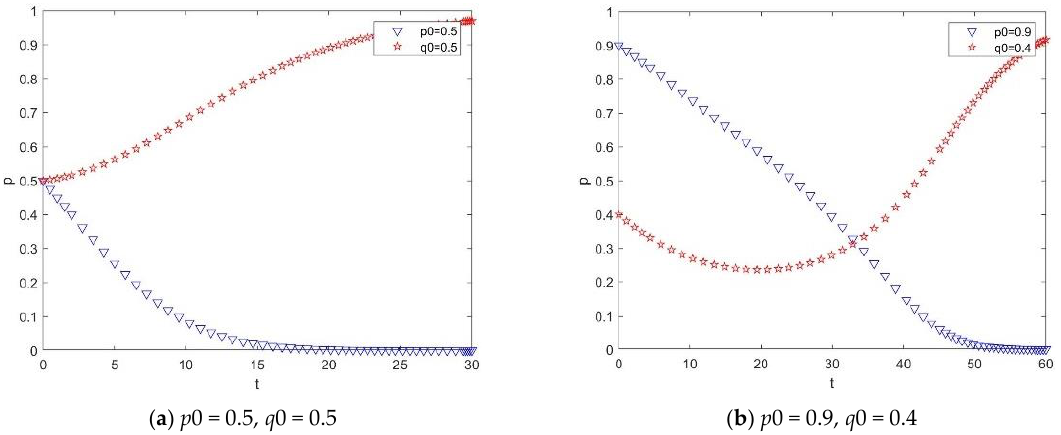
Figure 5. The effect of the amount of labor required for safety behavior and the gain of bravado D on the evolution results.